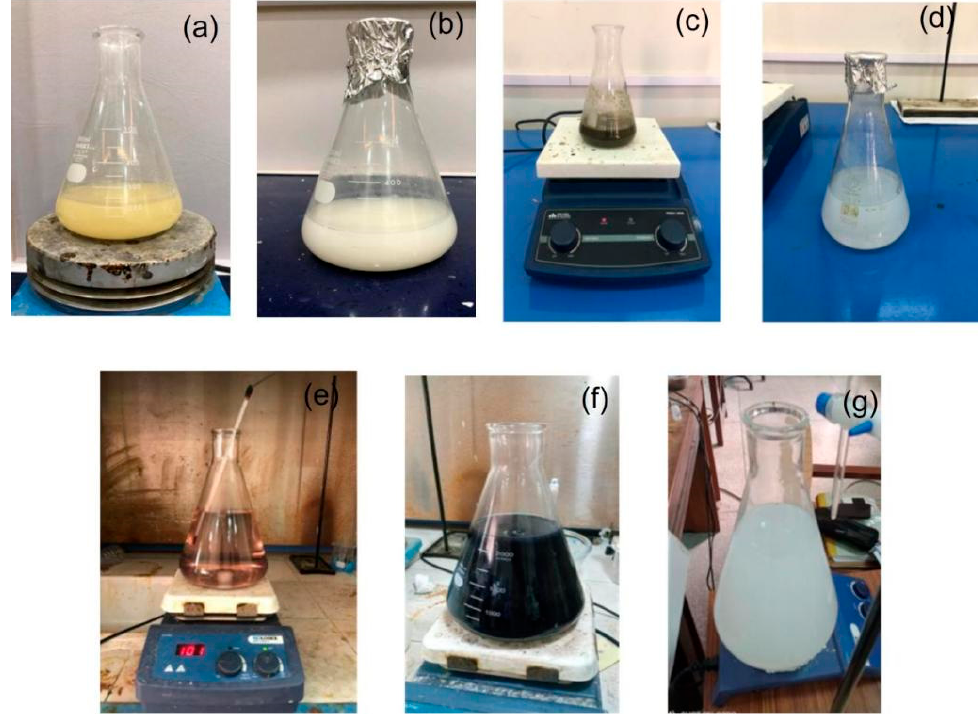
Figure 1. Preparation of titanium nanoparticles by three routes: ( a ) Bacillus subtilis culture, ( b ) Tita- nium nanoparticles formed from Bacillus subtilis culture, ( c ) Cassia fistula plant extract, ( d ) Titanium nanoparticles formed from Cassia fistula plant extract, ( e ) Initial TiCl 4 solution, ( f ) Color change in TiCl 4 solution after heating and ( g ) Titanium nanoparticles formed from hydrothermal heating.